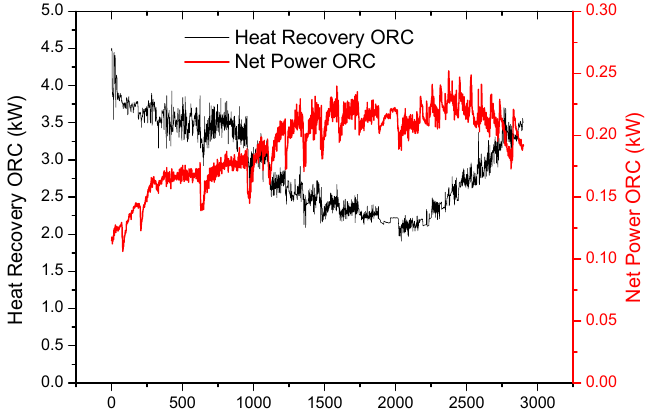
Figure 14. Heat recovery and net power of ORC unit.